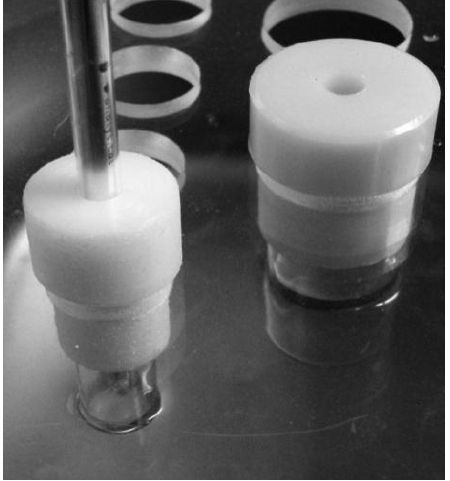
Figure 13. Teflon holders for inserting the measuring cell into 2.5 and 20 mL